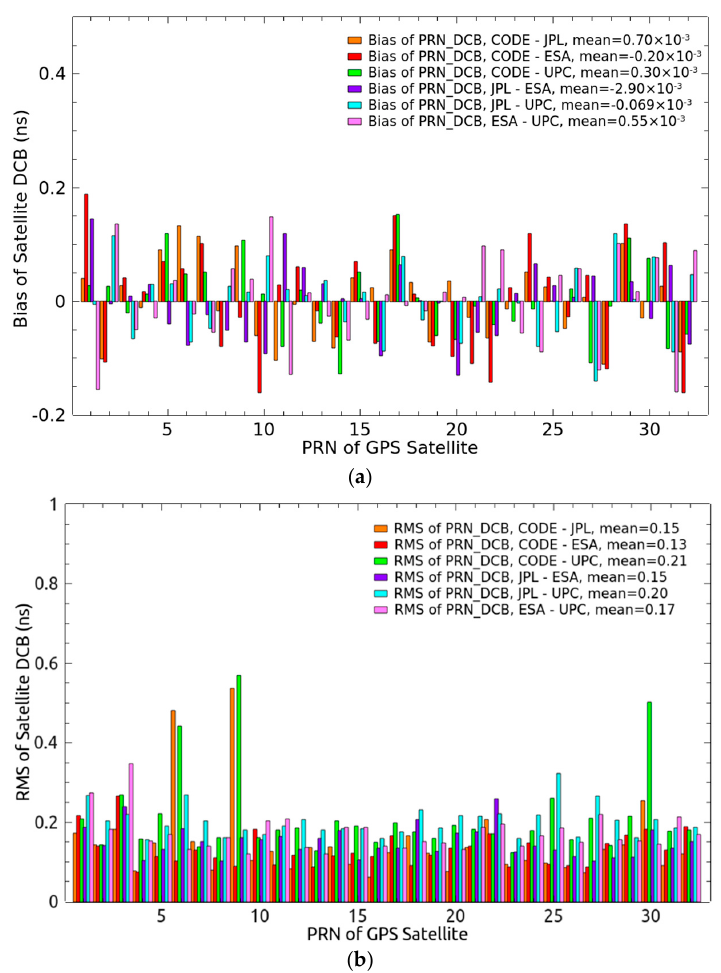
Figure 3. Differences in satellite Differential Code Biases (DCBs) among IAAC products in 2014. ( a ) Biases of satellites DCB comparisons among IAAC products. ( b ) RMS of differences in satellites DCB among IAAC products.